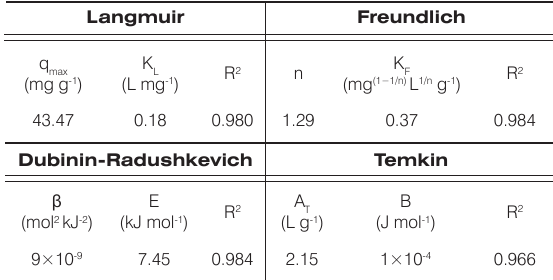
Figure 5. Langmuir (a) and Freundlich (b) adsorption isotherm for zinc sorption on Amberlite IRA410; C m = 5 g, V = 100 mL, 500 rpm. Table 2. Isotherm constants for zinc sorption on Amberlite IRA410.